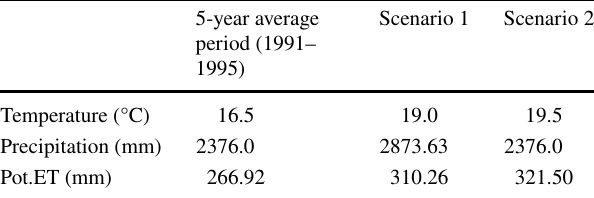
Fig. 10 Spatially distributed land-use maps for 1987 and 2009 Table 5 Changes in average value for temperature, precipitation and